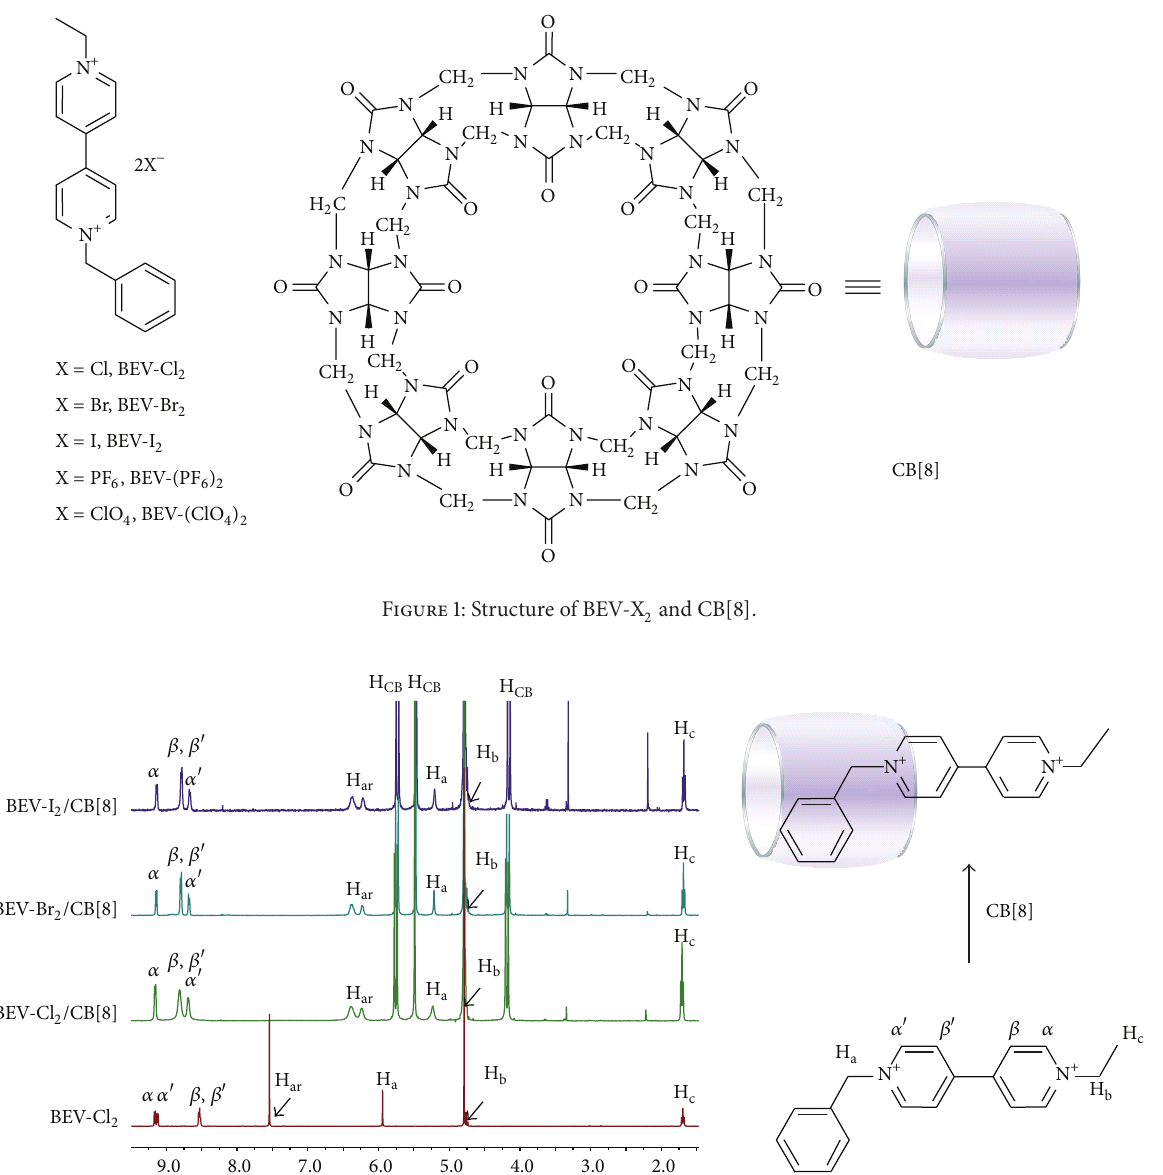
S2). The MS spectra gave a positively charged peak at